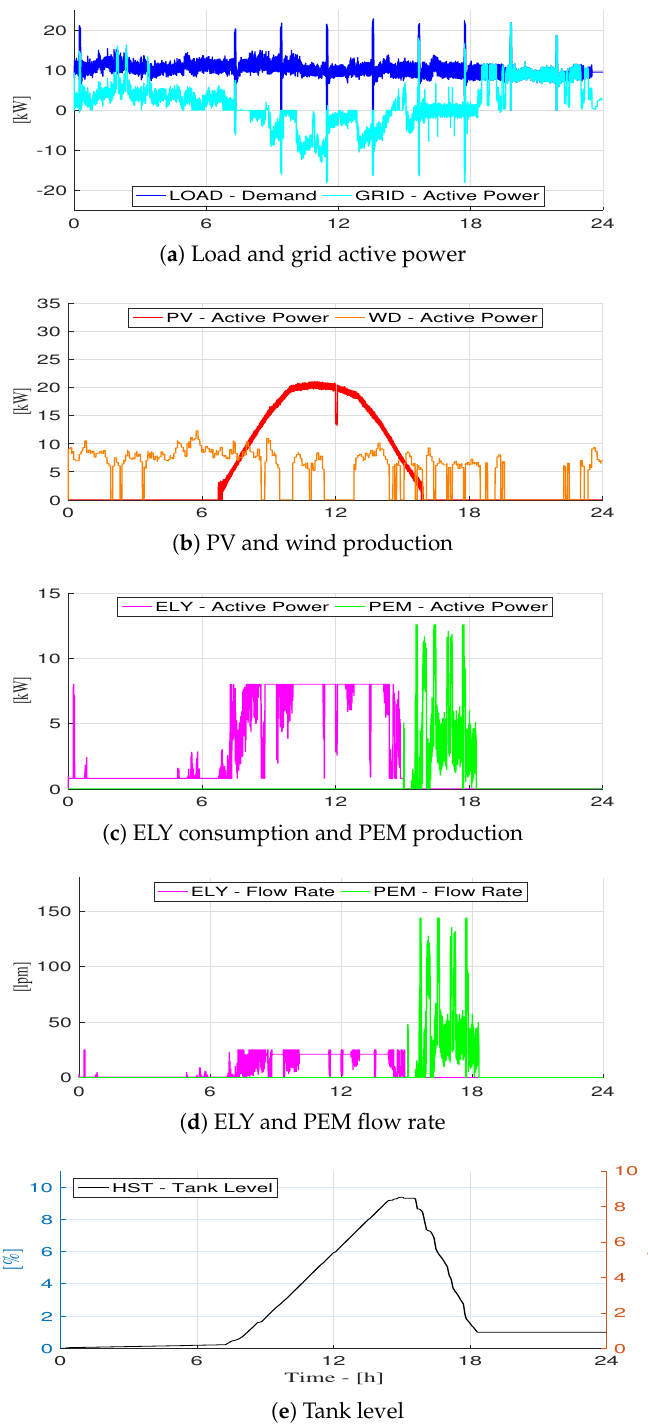
Figure 15. Response of the H µ G under a real load profile. Power balance at PCC in kW. In these three cases, the capability of the hydrogen tank is increased gradually, study- ing the response of the PEM fuel cell and the power balance at the PCC. Wind speed, solar irradiance and operating temperature of the photovoltaic system are common for all the cases. In the first case (one photovoltaic system, one wind turbine system and one electrolyser), the total energy produced by RES is 253.07 kWh, which is almost equal to the energy of the load (245.03 kWh). When the system operates without the hydrogen system, the grid contribution of the system is − 8.04 kWh (i.e., there is an injection of power in